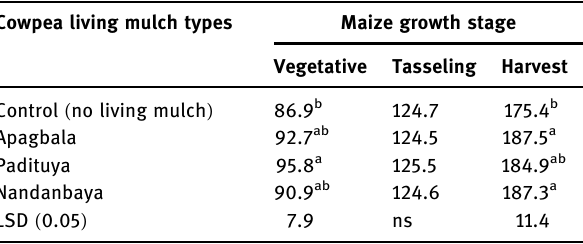
Table 4: Maize plant height ( cm ) as a ff ected by cowpea living mulch types ( average of the two maize varieties ) Cowpea living mulch